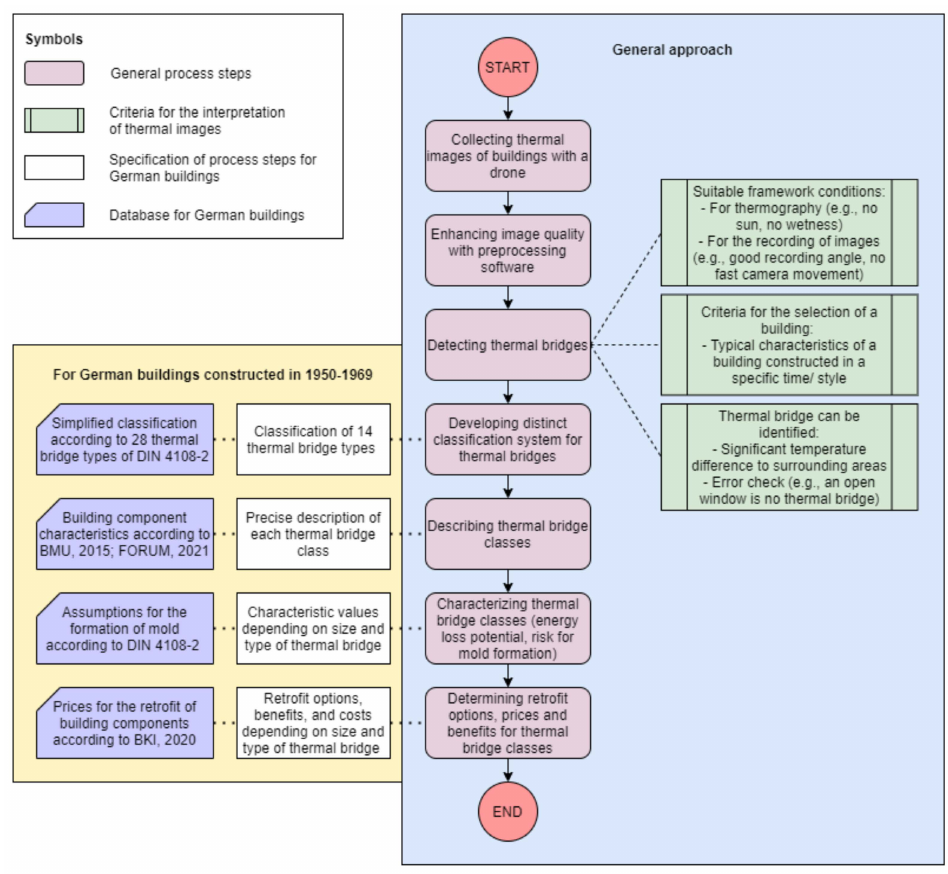
Figure 1. Research approach of this study presented in a flow diagram. The focus of this paper is on buildings constructed in Germany in the time between 1950 and